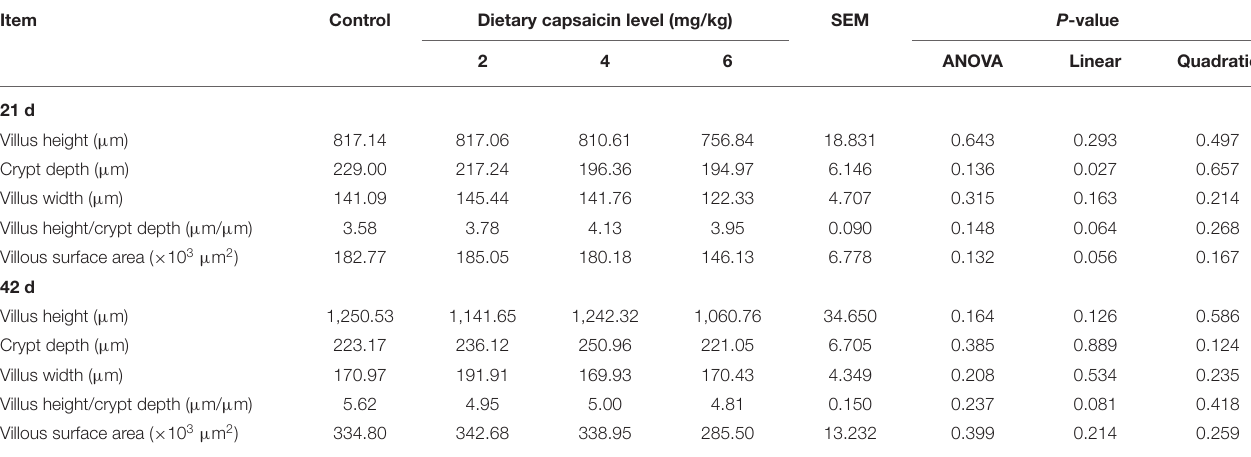
TABLE 9 | Effects of different levels of capsaicin on the ileal morphology of